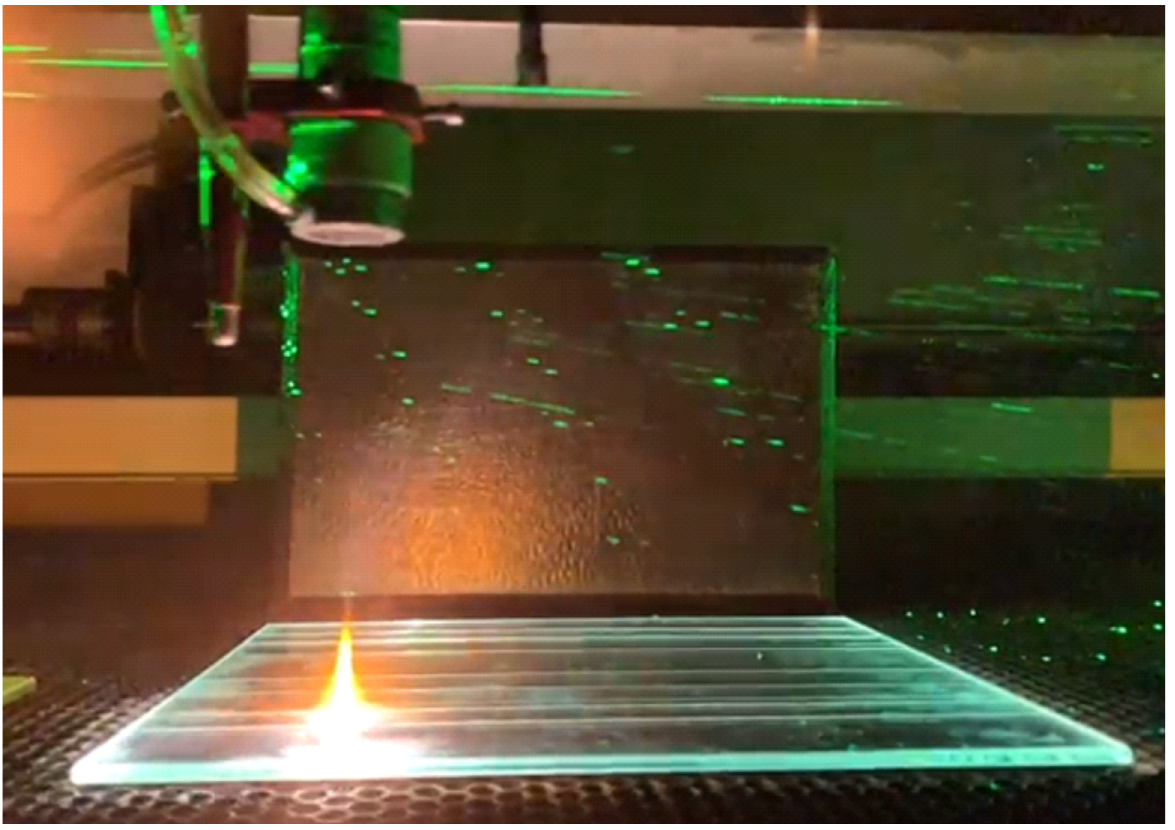
Figure 6. Visible effects of CW CO 2 laser interaction with soda-lime glass. F = 127 mm. Air assistance protects laser optics and do not influence heat